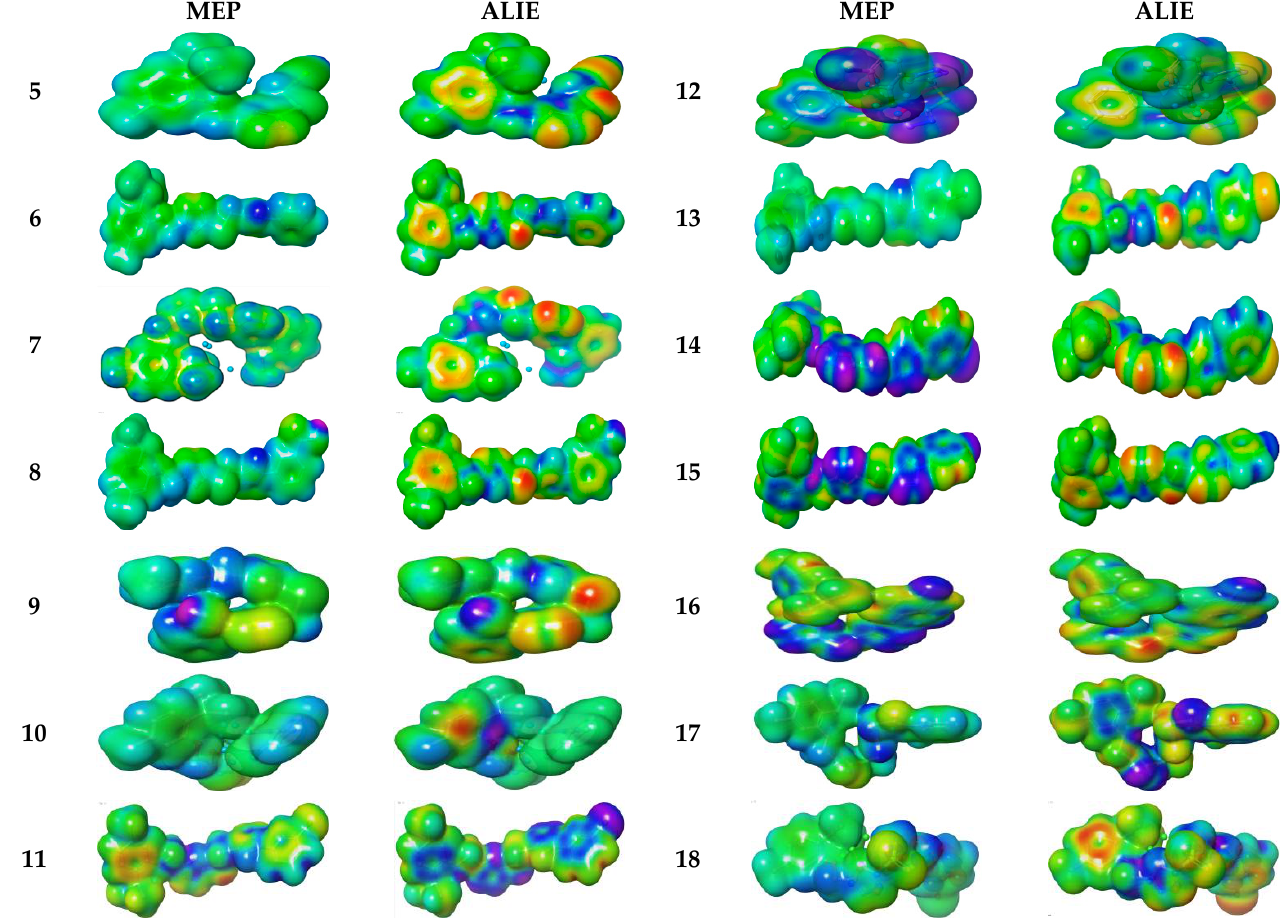
Figure 3. Molecular electrostatic potential surfaces views of 5 – 18.